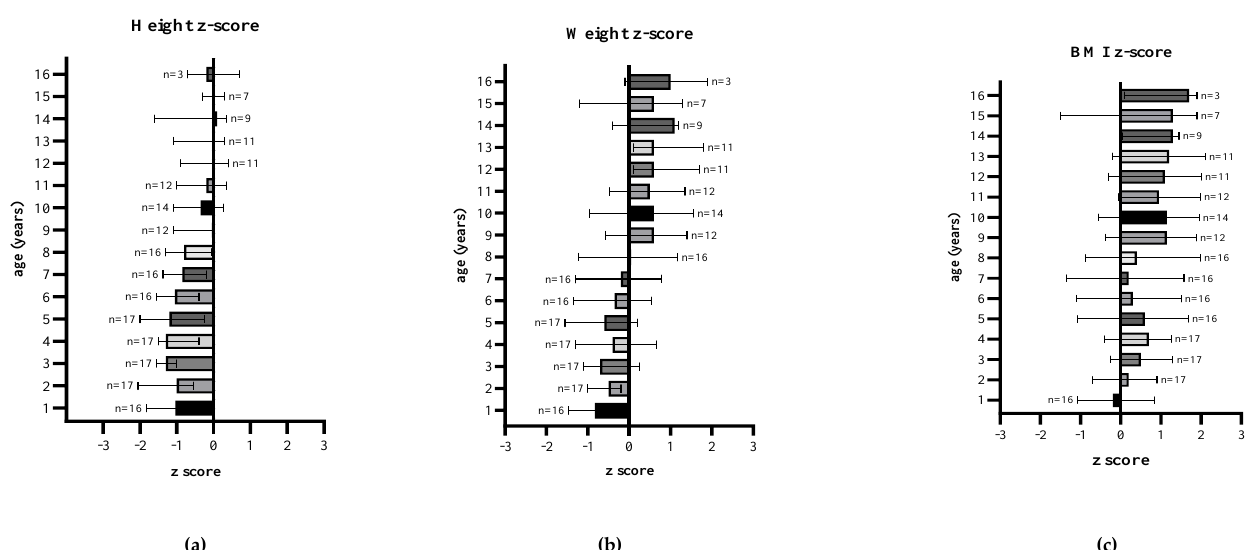
Figure 1. ( a ) Median height-for-age, ( b ) median weight-for-age, and ( c ) median BMI-for-age z-scores of patients with HTI from first year to 16 years of age.